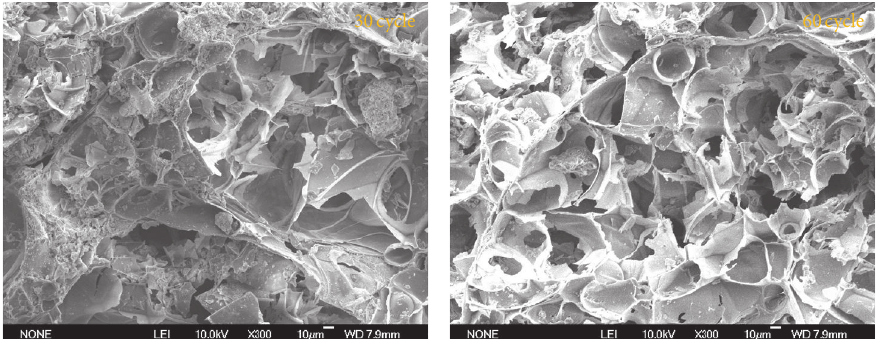
Figure 13: SEM graphs of GBH mortar on insulating layer.